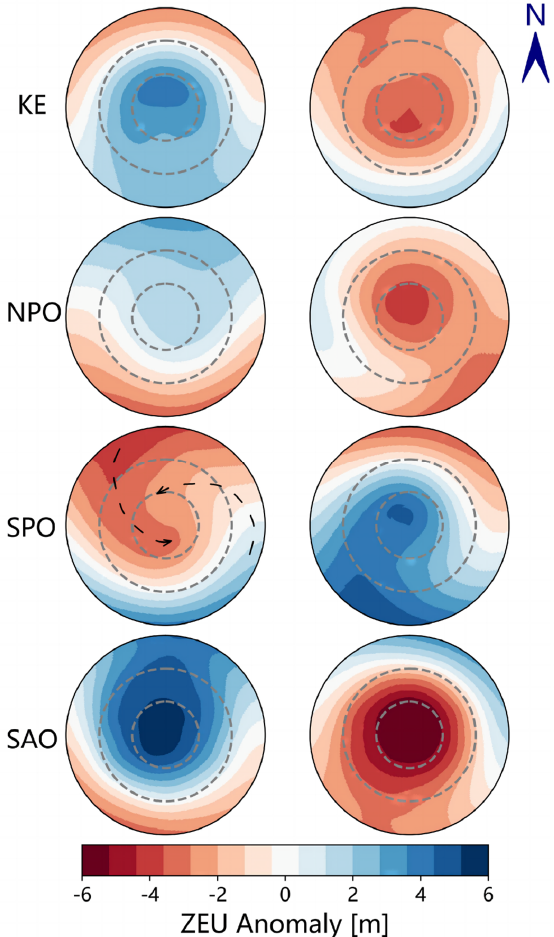
Figure 5. Two−dimensional distributed graph of ZEU′ with normalized radius in eddy disturbance Figure 5. Two − dimensional distributed graph of ZEU (cid:48) with normalized radius in eddy disturbance with the left column in AE and the right column in CE. ZEU′s are linearly interpolated into a 150*360 with the left column in AE and the right column in CE. ZEU (cid:48) s are linearly interpolated into a grid and drawn in polar coordinates. From top to bottom, there are four regions: KE, NPO, SPO, and SAO. The inner-dashed circle is 0.5r, the middle-dashed circle is 1r, and the outermost circle is 1.5r. The direction of the black dashed line is the coupling direction of the two polar anomalies.